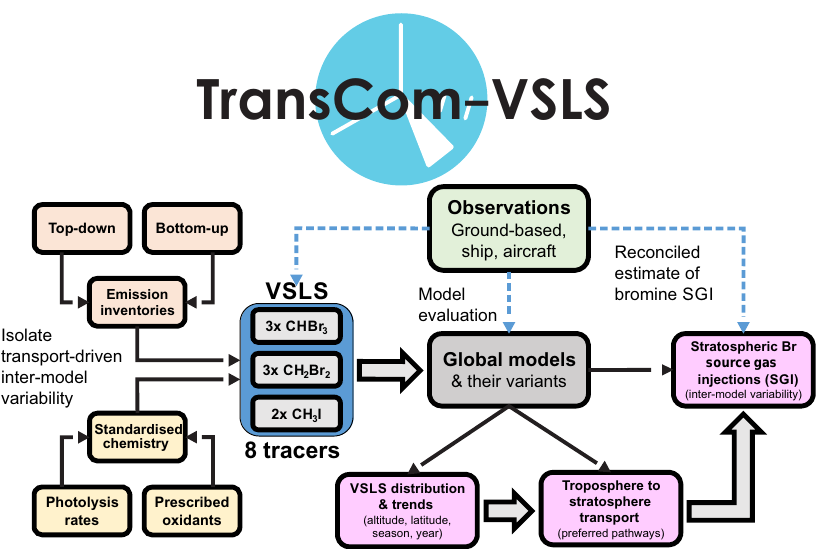
Figure 1. Schematic of the TransCom-VSLS project